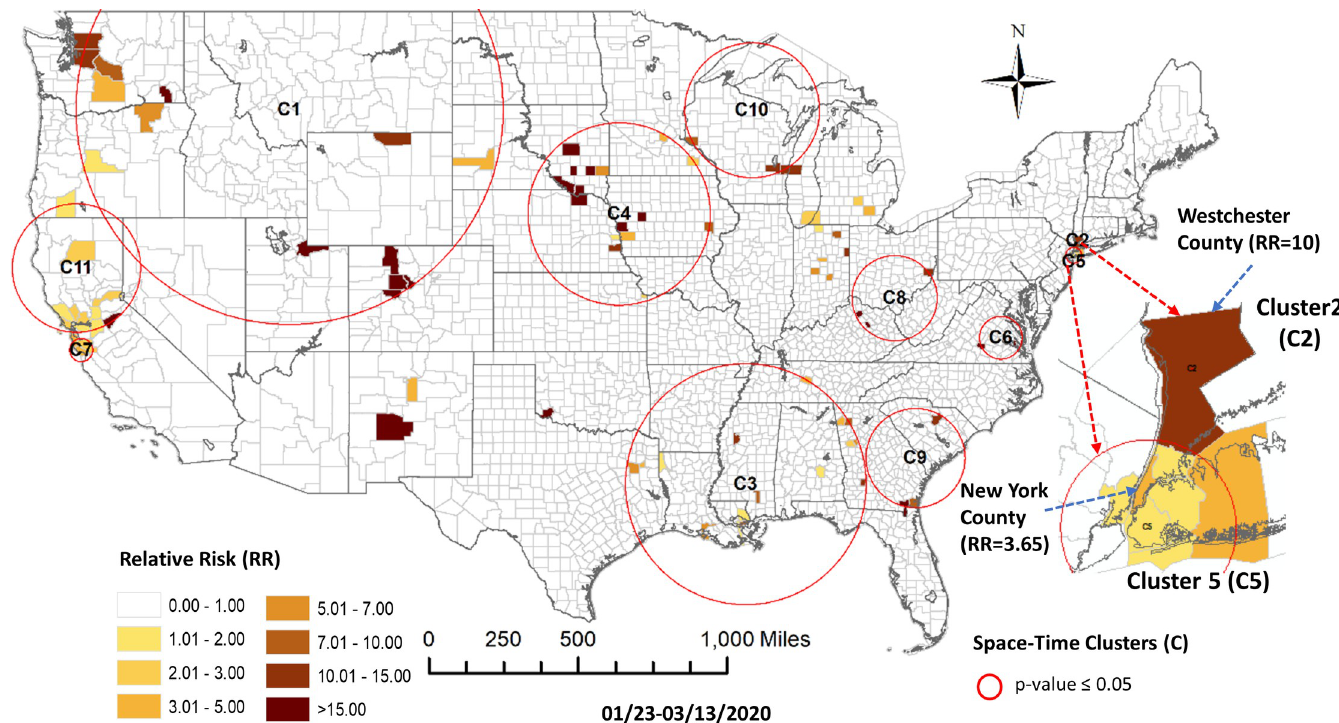
Fig 1. COVID-19 space-time scan hotspots in the United States at the county level from 1/22/-3/13/2020.